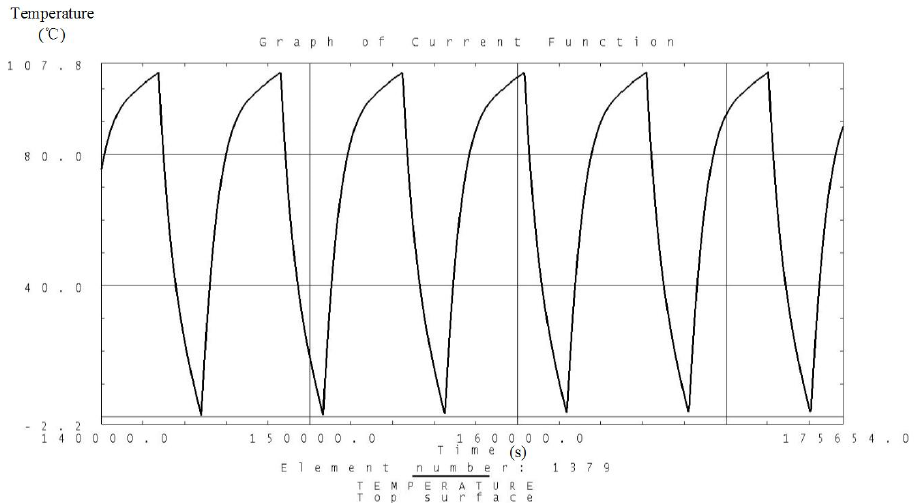
Figure 12. Analysis result of the temperature variation curve of the solar panels under low temperature conditions.